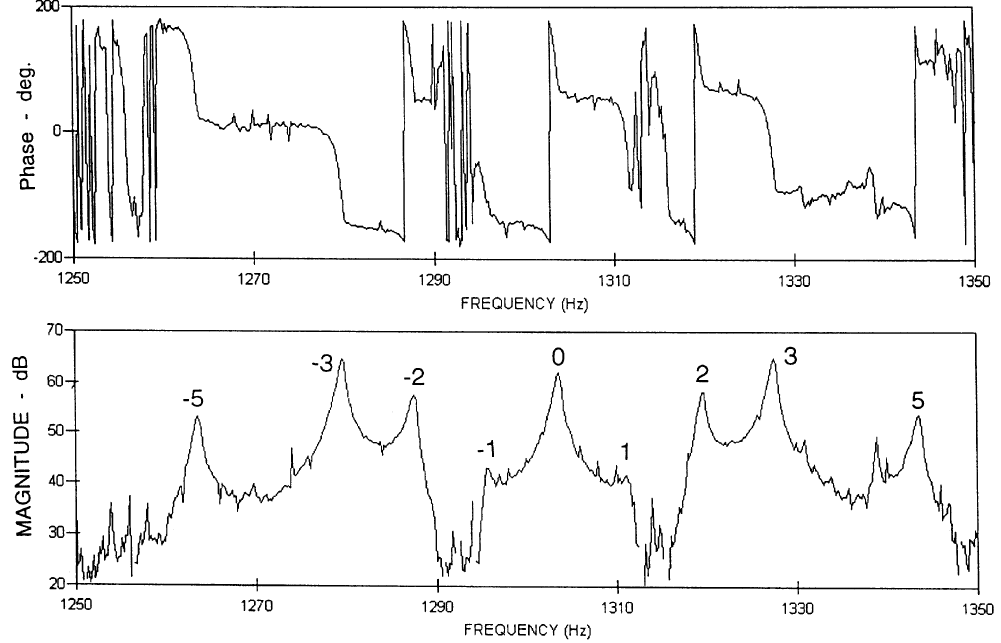
Fig. 6. CSLDV response spectrum for a cantilever beam – triggered from the scan